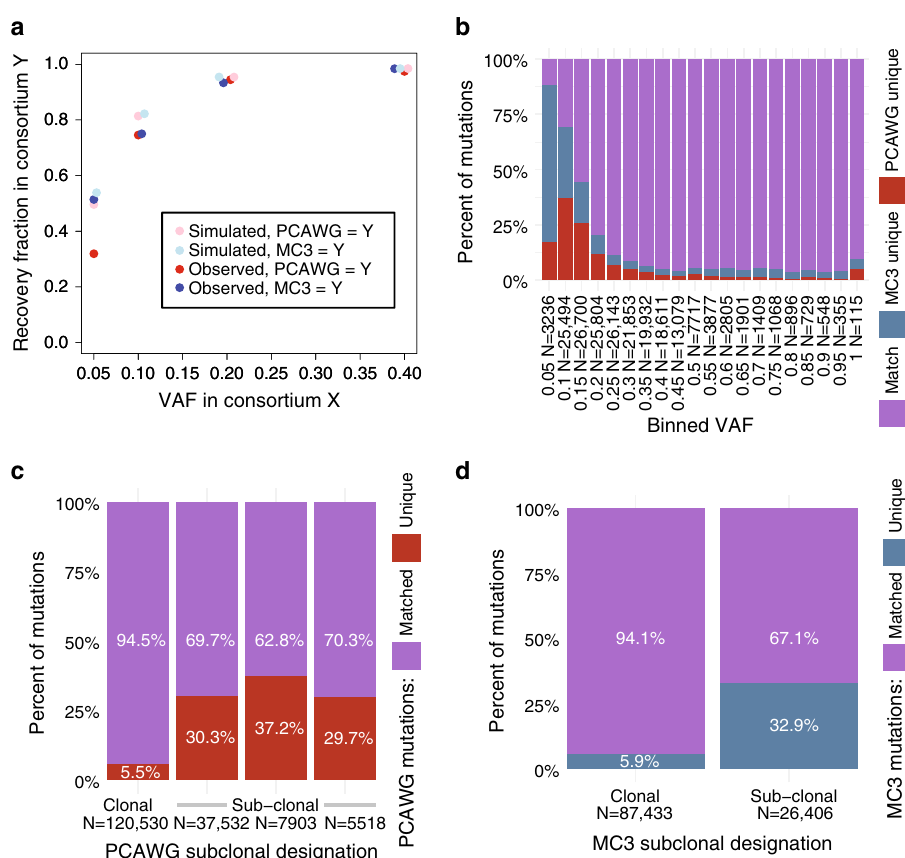
Fig. 3 Recoverability simulation and effects of subclones on mutation concordance. a Observed recovery rate of PCAWG variants in MC3 (red) and of MC3 variants in PCAWG (blue), alongside sequencing noise simulations calculated from random draws of a binomial model that incorporates the VAF and estimated read depth at each site (light red simulates PCAWG recoverability of MC3 variants, and light blue simulated MC3 recoverability of PCAWG variants). Y -axis is described with legend. X -axis displays VAF of the comparative data set in regard to Y . b A stacked bar chart displays the proportion of matched and unique variants ( y -axis) for different VAF bins ( x -axis). 180 variants did not provide read count information and were removed from this fi gure. c Stacked proportional histogram shows the fractions of PCAWG matched mutations (purple) and PCAWG-unique mutations (red). Mutations were restricted to SNVs, and subclonality predictions are indicated as either ‘ Clonal ’ or ‘ Sub-clonal ’ . Columns 2 – 4 re fl ect sub-clonal assignment provided by PCAWG (Note: only a few samples reported fi ve predicted subclones and were not included in this analysis). The number of variants represented for each clonal assignment is shown on the x -axis. d Similar to panel c , a stacked proportional histogram illustrates the proportion of matched and unique variants for MC3 which provide estimates of total number of matched or unique variants called by